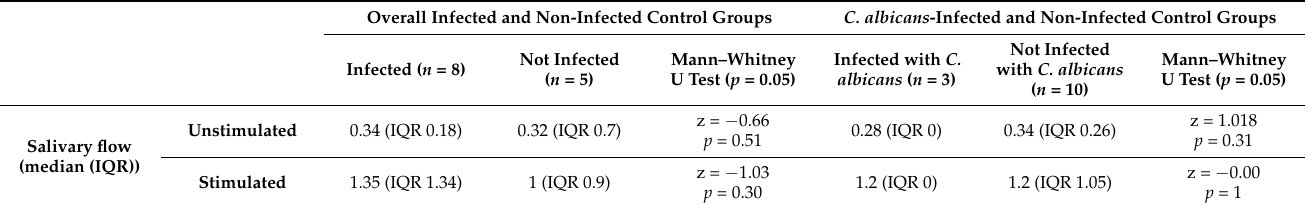
Table 4. Differences between infected and non-infected control groups (overall infected patients and C. albicans -infected